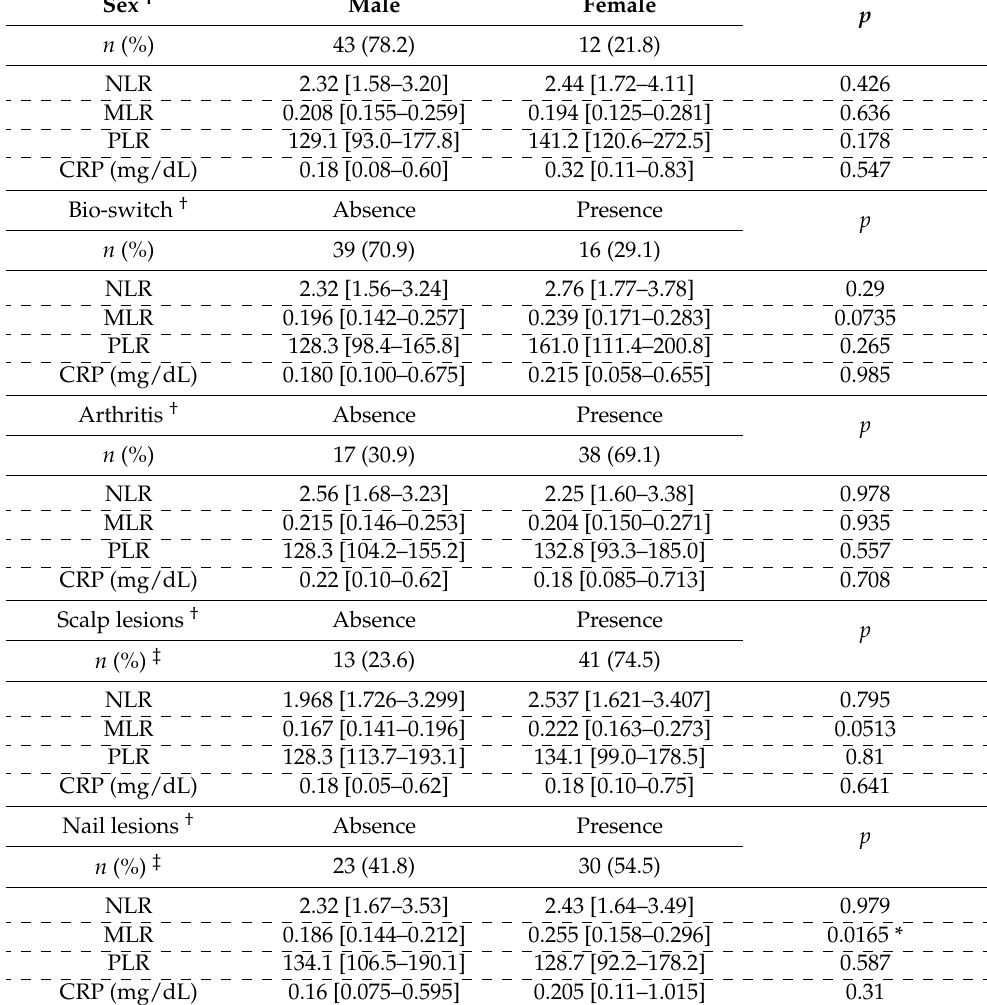
Table 2. The relations between patients’ background factors and baseline values of neutrophil-to- lymphocyte ratio (NLR), monocyte-to-lymphocyte ratio (MLR), platelet-to-lymphocyte ratio (PLR) or C-reactive protein